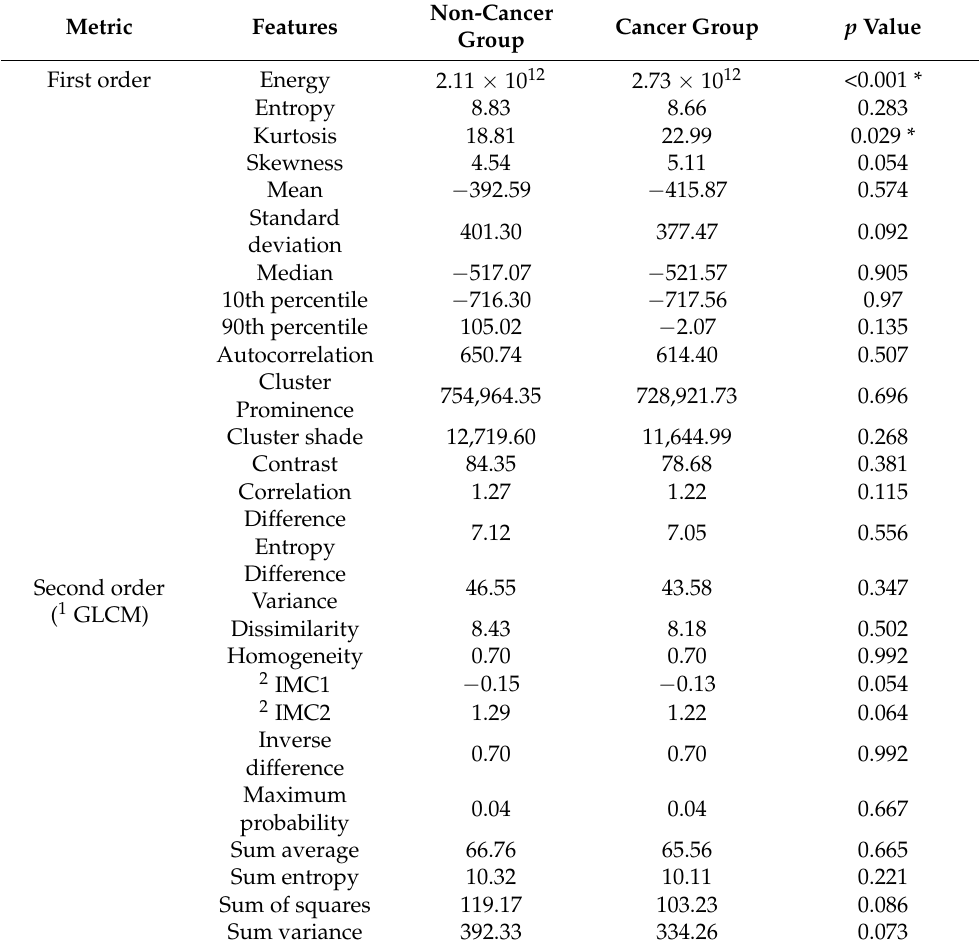
Table 2. Comparisons of and representative CT radiomics features of non-cancer and cancer groups in the training cohort. Metric Features